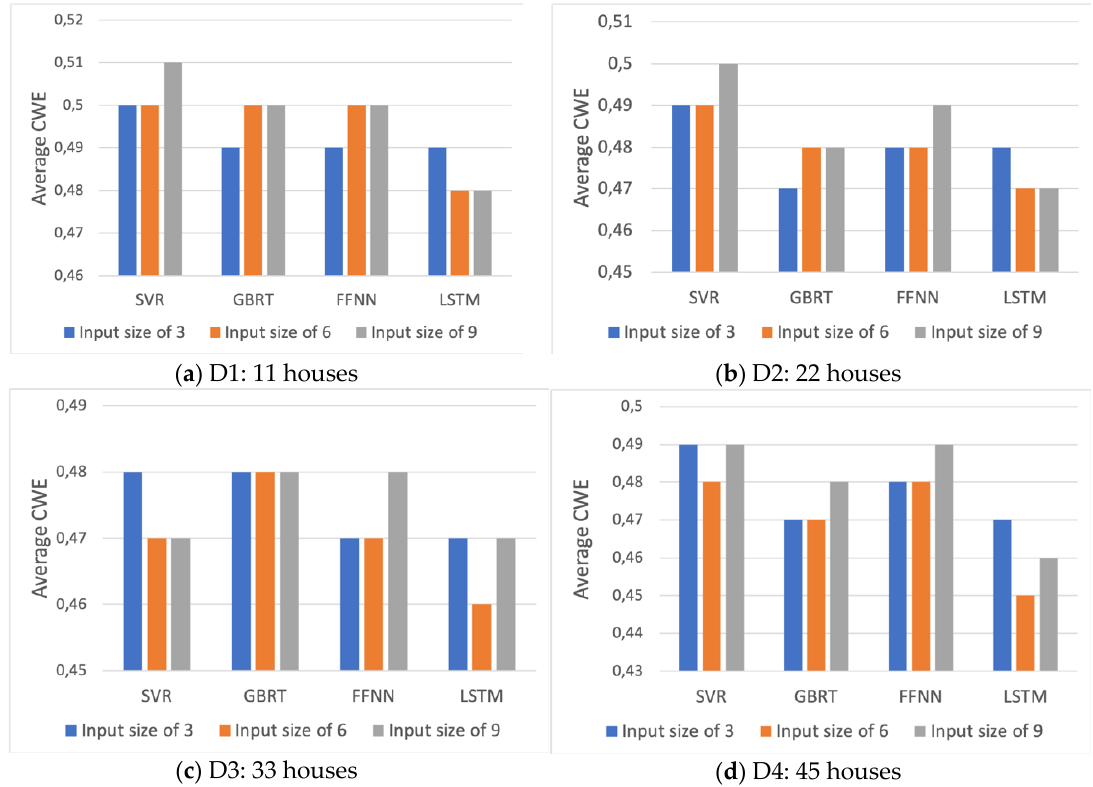
Figure 7. Error analysis with respect to the number of input variables and the size of the training set.